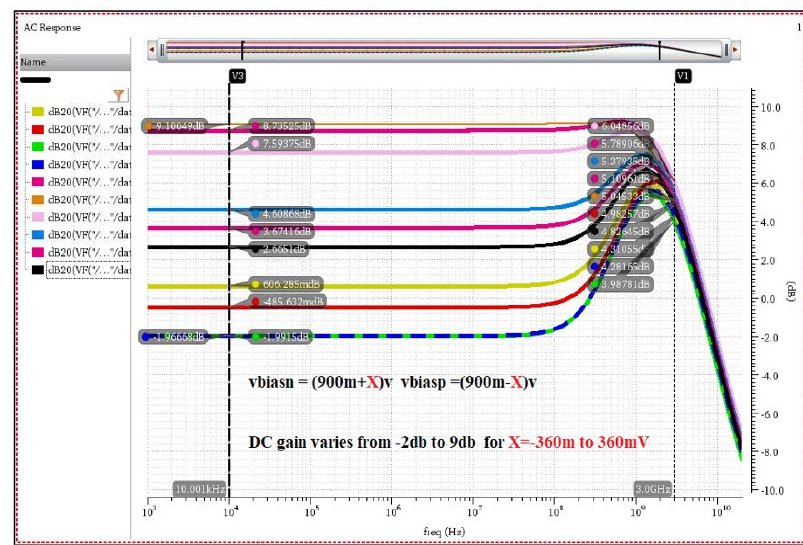
Figure 11. Simulated Frequency Response for the CTLE.